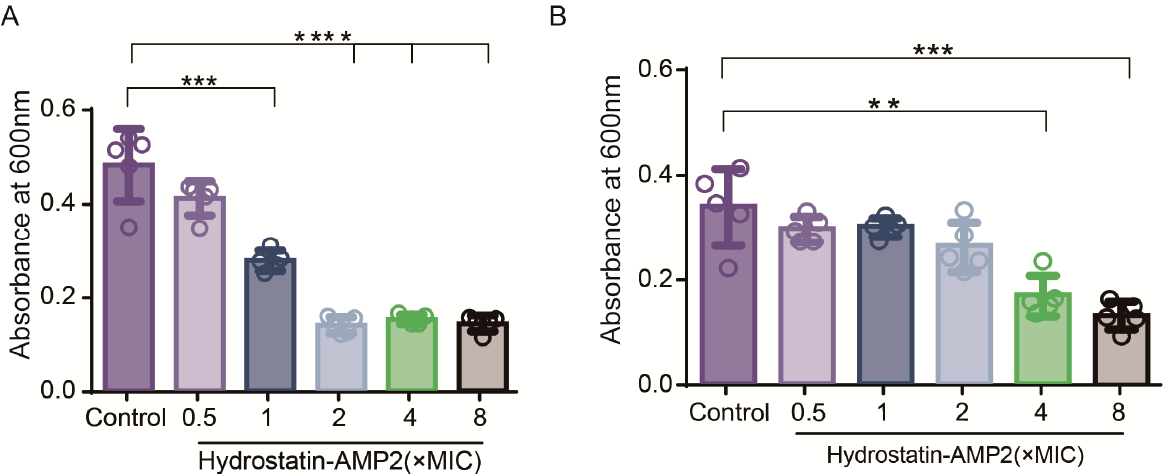
Figure 5. Effects of Hydrostatin-AMP2 on S. aureus biofilm. ( A ) Biofilm inhibition activity of Hydrostatin-AMP2. ( B ) Biofilm eradication activity of Hydrostatin-AMP2. Data represent mean ± SD values of three independent experiments performed in quintuplicate. **, p < 0.01; ***, p < 0.001; ****, p < 0.0001 (significantly different compared with the control).